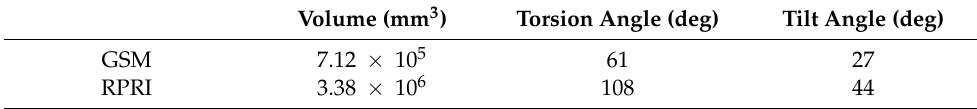
Table 2. Workspace analysis results.